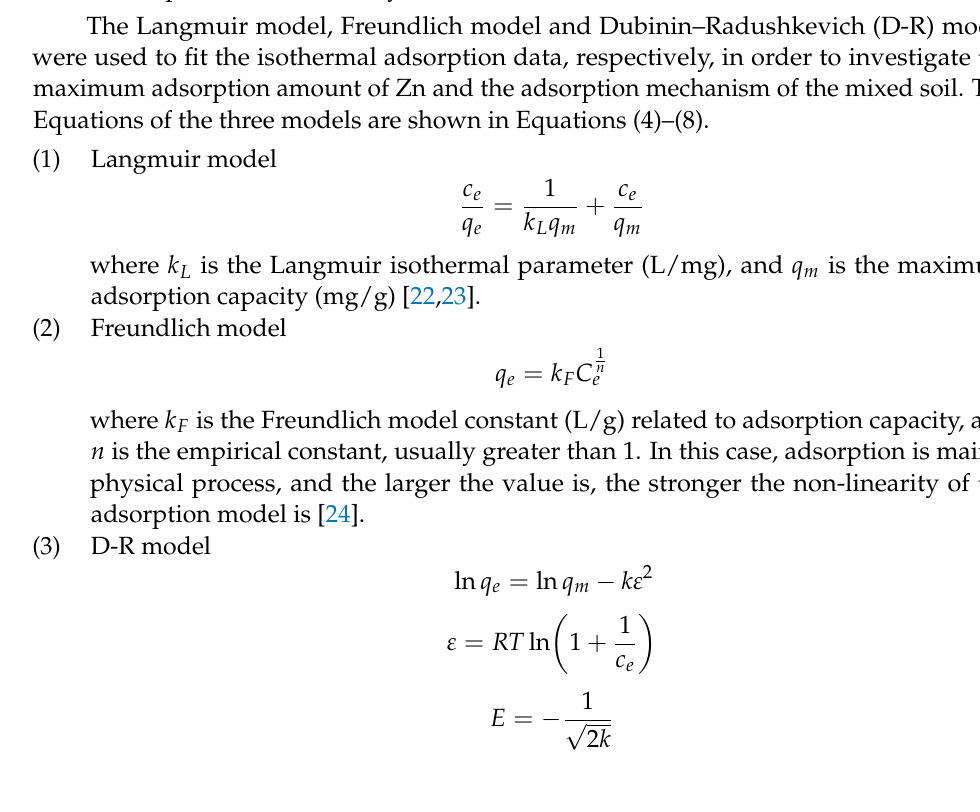
maximum adsorption amount of Zn and the adsorption mechanism of the mixed soil. The Equations of the three models are shown in Equations